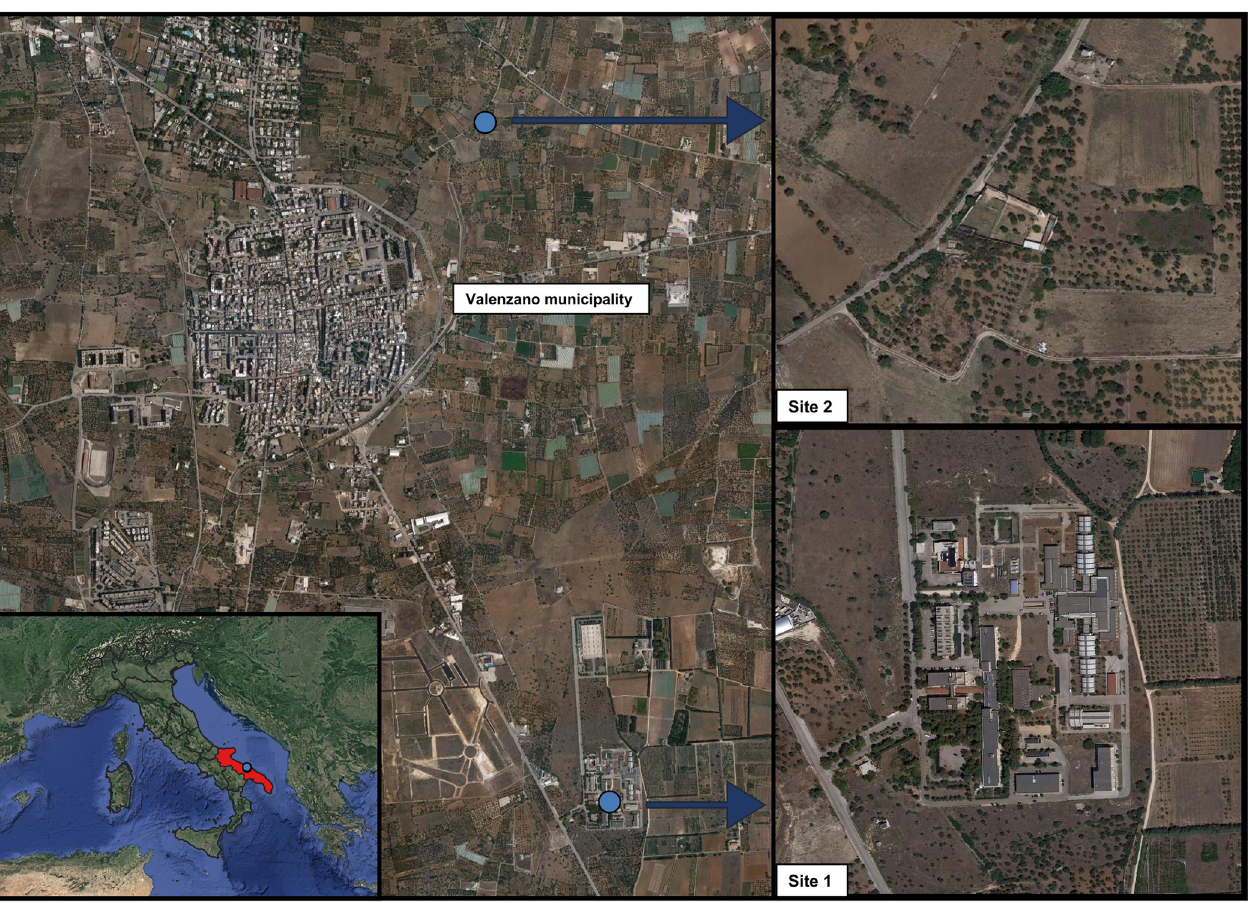
Fig 2. Geographic location of reptile and dog blood sample collection sites and sand fly capturing, in the surroundings of Valenzano municipality, Apulia, Region. (Publicly available satellite shapefiles from http://mt0.google.com/vt/lyrs=s&hl=en&x={x}&y={y}&z={z}; in QGIS